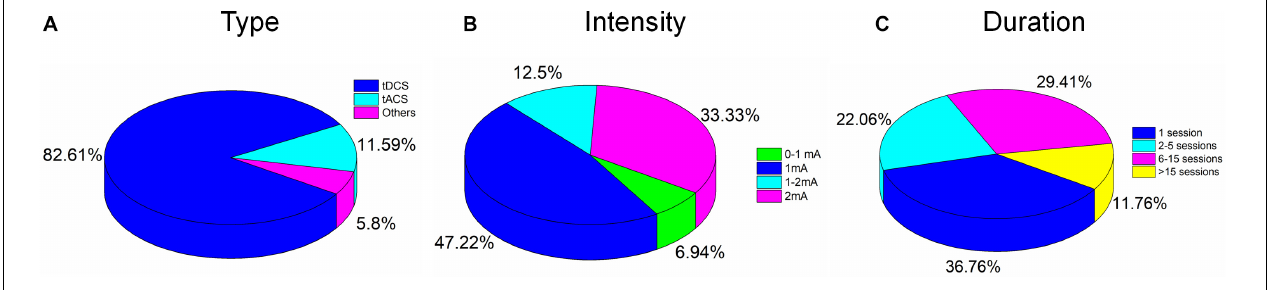
integration of noninvasive neuroimaging and neuromodulation methods in nine brain disorders to the best of our